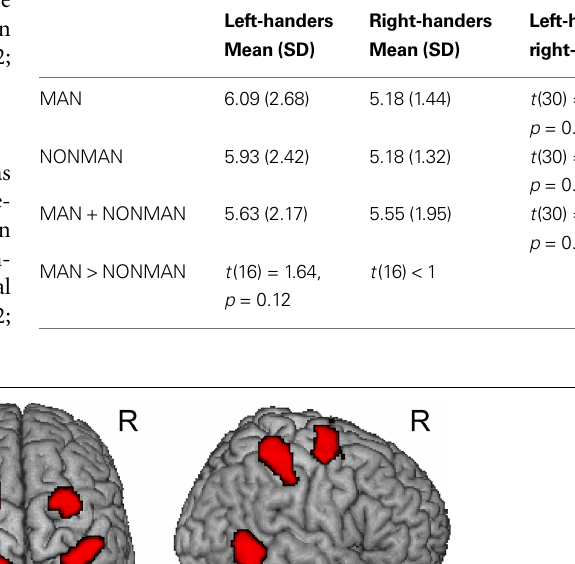
Table 1 | Behavioral results. Mean (and standard deviation) imagining times in seconds for left-handers (left column) and right-handers (middle column), and the results of a independent samples t -test to test for a difference in imagining times between the groups and within-group differences between MAN and NONMAN durations (right column). Data are displayed separately for MAN alone, NONMAN alone and MAN +